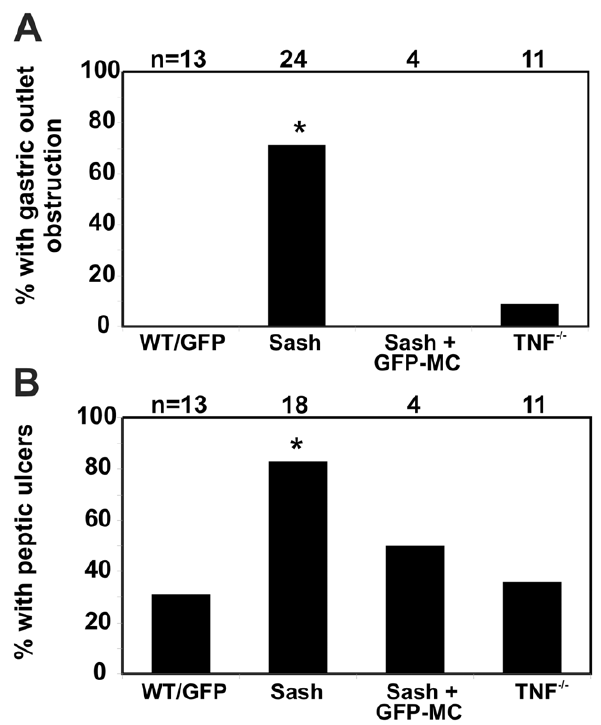
Figure 2. Mast cell-deficient mice are more susceptible to peptic ulceration when exposed to piroxicam. Significantly more Sash mice developed grossly evident gastric outlet obstruction defined as gastric enlargement . 4 6 normal (A) and histologically detected peptic ulcers (B) when exposed to piroxicam, compared with WT or Tnf 2 / 2 mice. Both the increased sensitivity to peptic ulcers and gastric outlet obstruction appeared to be mast cell-dependent, since they reversed when Sash mice were reconstituted with mast cells (Sash + GFP- MC), but were not TNF-dependent since Tnf 2 / 2 mice had a similar incidence of gastric ulceration and gastric outlet obstruction as WT mice. * indicates p # 0.05 relative to WT.